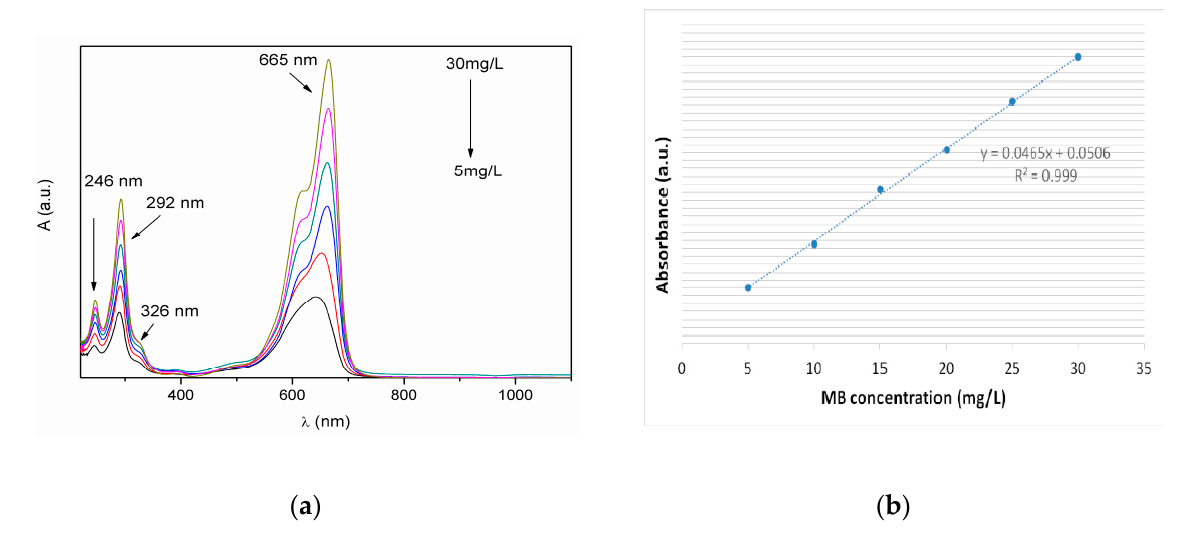
Figure 14. ( a ) UV-vis spectra of MB at different concentrations; ( b ) the calibration curve.